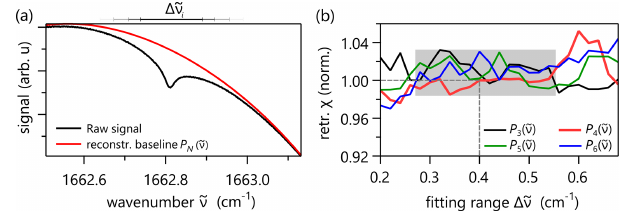
Figure 9. (a) Fitting of the measured transmission data. The choice of the baseline polynomial (red) and the selected range (cid:49) ˜ ν i to eval- uate a measured spectrum need to be optimized. Varying these pa- rameters can influence the retrieved H 2 O mixing ratio χ , as shown in (b) after repeated evaluation of the same spectrum. Using poly- nomial orders P N ( ˜ ν) between 3 and 6, the standard deviation of all fitting results within the gray highlighted region amounts to 1.1% relative to the finally selected configuration for the analysis of the data, i.e., (cid:49) ˜ ν = 0 . 4cm − 1 and P 4 ( ˜ ν)